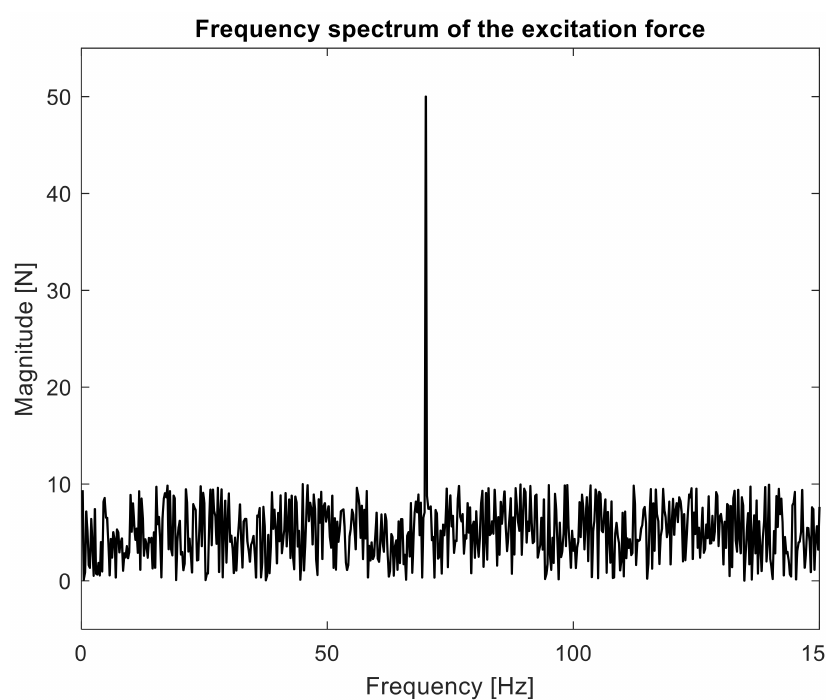
Figure 4. The frequency spectrum of the excitation